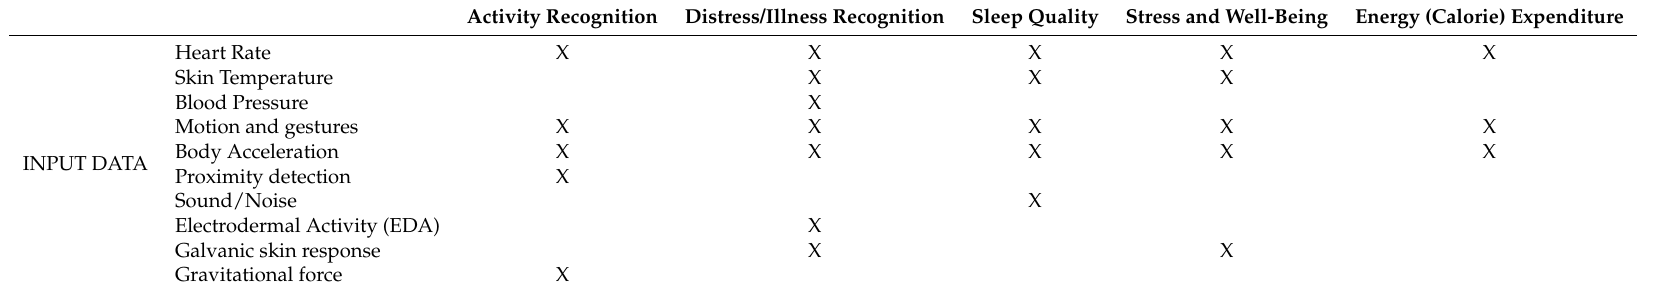
Table 4. Type data used in intelligent data